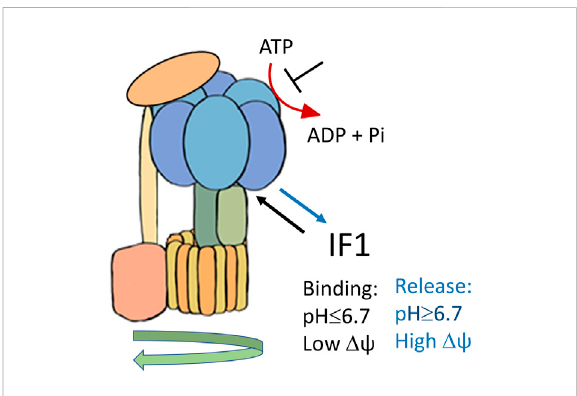
FIGURE 1 Schematic representation of IF1 binding to F1Fo-ATPase, favoured by acidic pH and membrane potential ( Δψ )